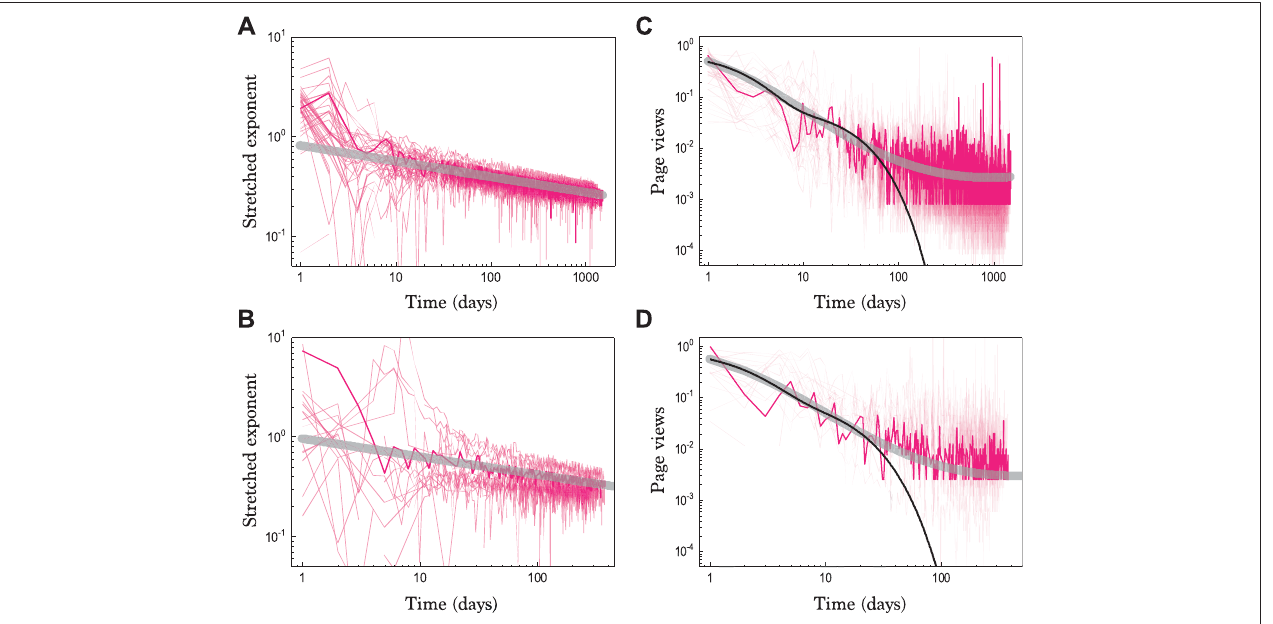
FIGURE2| Timedependenceofstretchedexponents.Thetime-dependentstretchedexponents β ( t ) calculatedfromthenormalizedpageviewsin Figure1 show the nonexponentiality ( β ( t ) ≠ 1) and particularly the power-law time dependence as β ( t ) (cid:1) c t δ . The fi tted power-law β ( t ) curve is depicted by the bold line, respectively (A,B) . Basedon the fi tting of β ( t ) (cid:1) c t δ , thenormalized page views s (cid:1) exp [−( t / α ) β ( t ) ] are modeled asshown by thebold line (C,D) ,whilethebiexponentialfunction(the black line) is inappropriate to the long-tailed popularity dynamics. For a guide, srep00223 (A,C) and srep07971 (B,D) are marked with the solid lines.